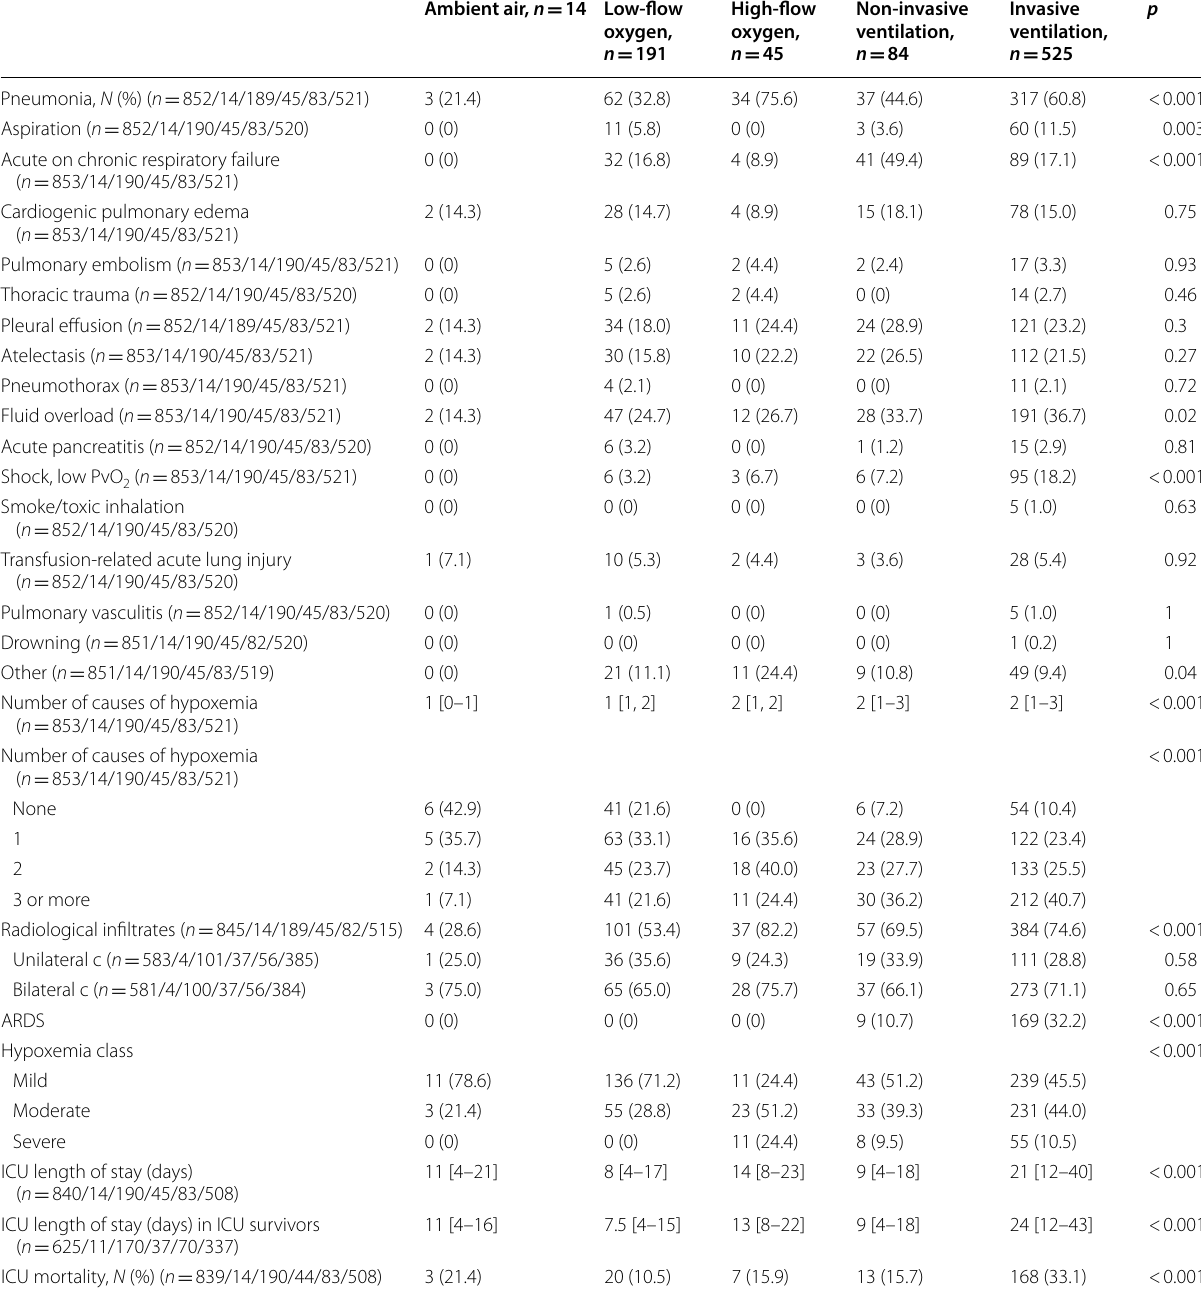
Table 4 Mechanisms/causes of hypoxemia and radiological findings according to oxygenation modalities